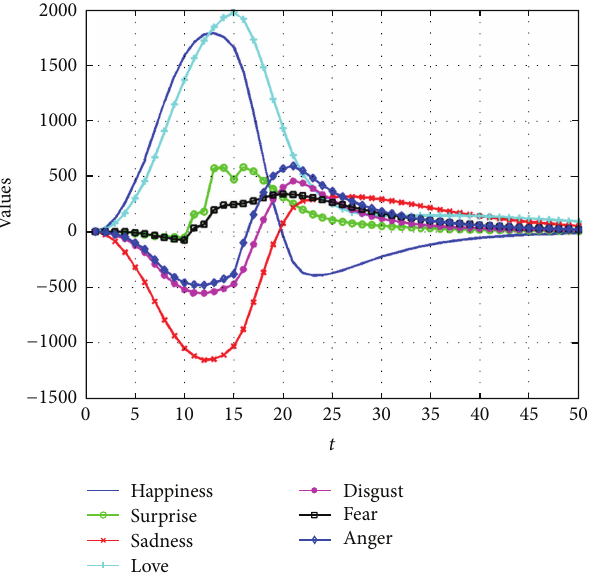
Figure 6: Graph of emotions generated by senior